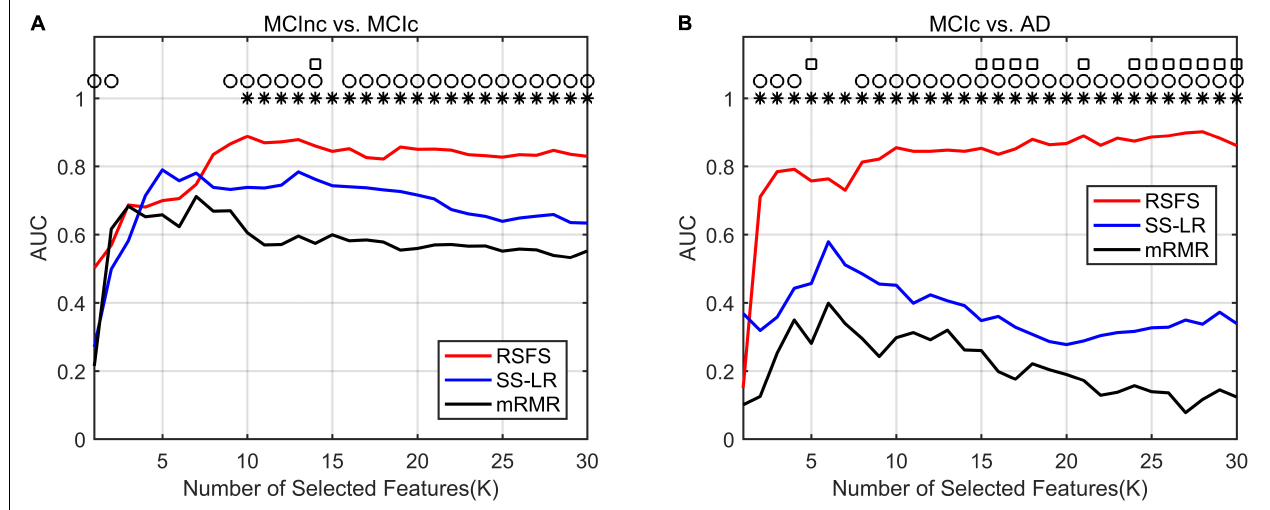
FIGURE 3 | Comparison of AUC scores of three algorithms performed SVM classifier. Subgraphs (A) and (B) represent AUC scores with the number of features K of MCInc vs. MCIc, and MCIc vs. AD. Indicate the classification performance of the RSFS algorithm and SS-LR algorithm is significantly different. Indicate the classification performance of the RSFS algorithm and mRMR algorithm is significantly different. (cid:35) (cid:3) Indicate the classification performance of the mRMR algorithm and SS-LR algorithm is significantly